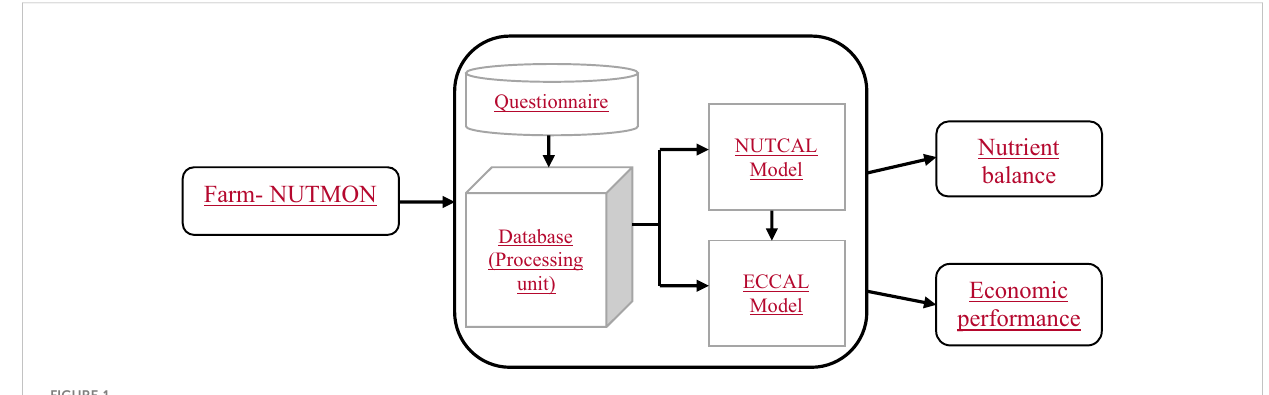
FIGURE 1 A schematic representation of a farm NUTMON (Source: